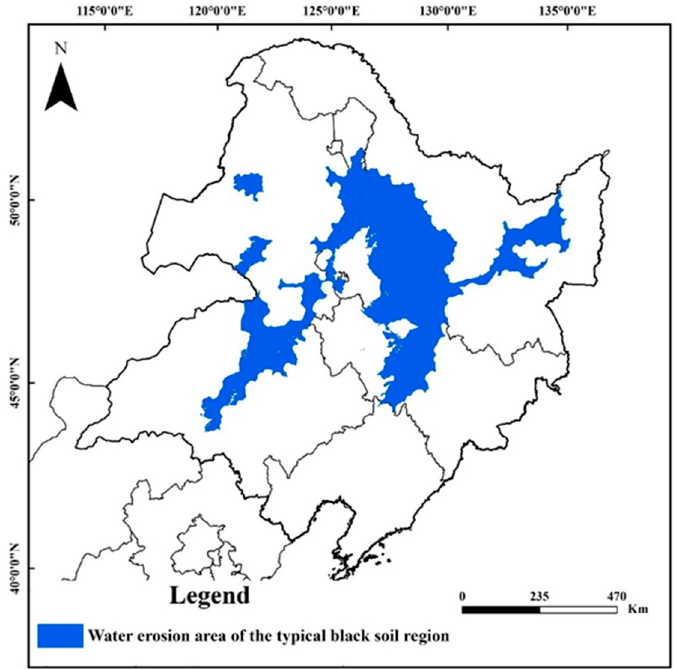
Figure 1. Location of the study area (water erosion area of the typical black soil